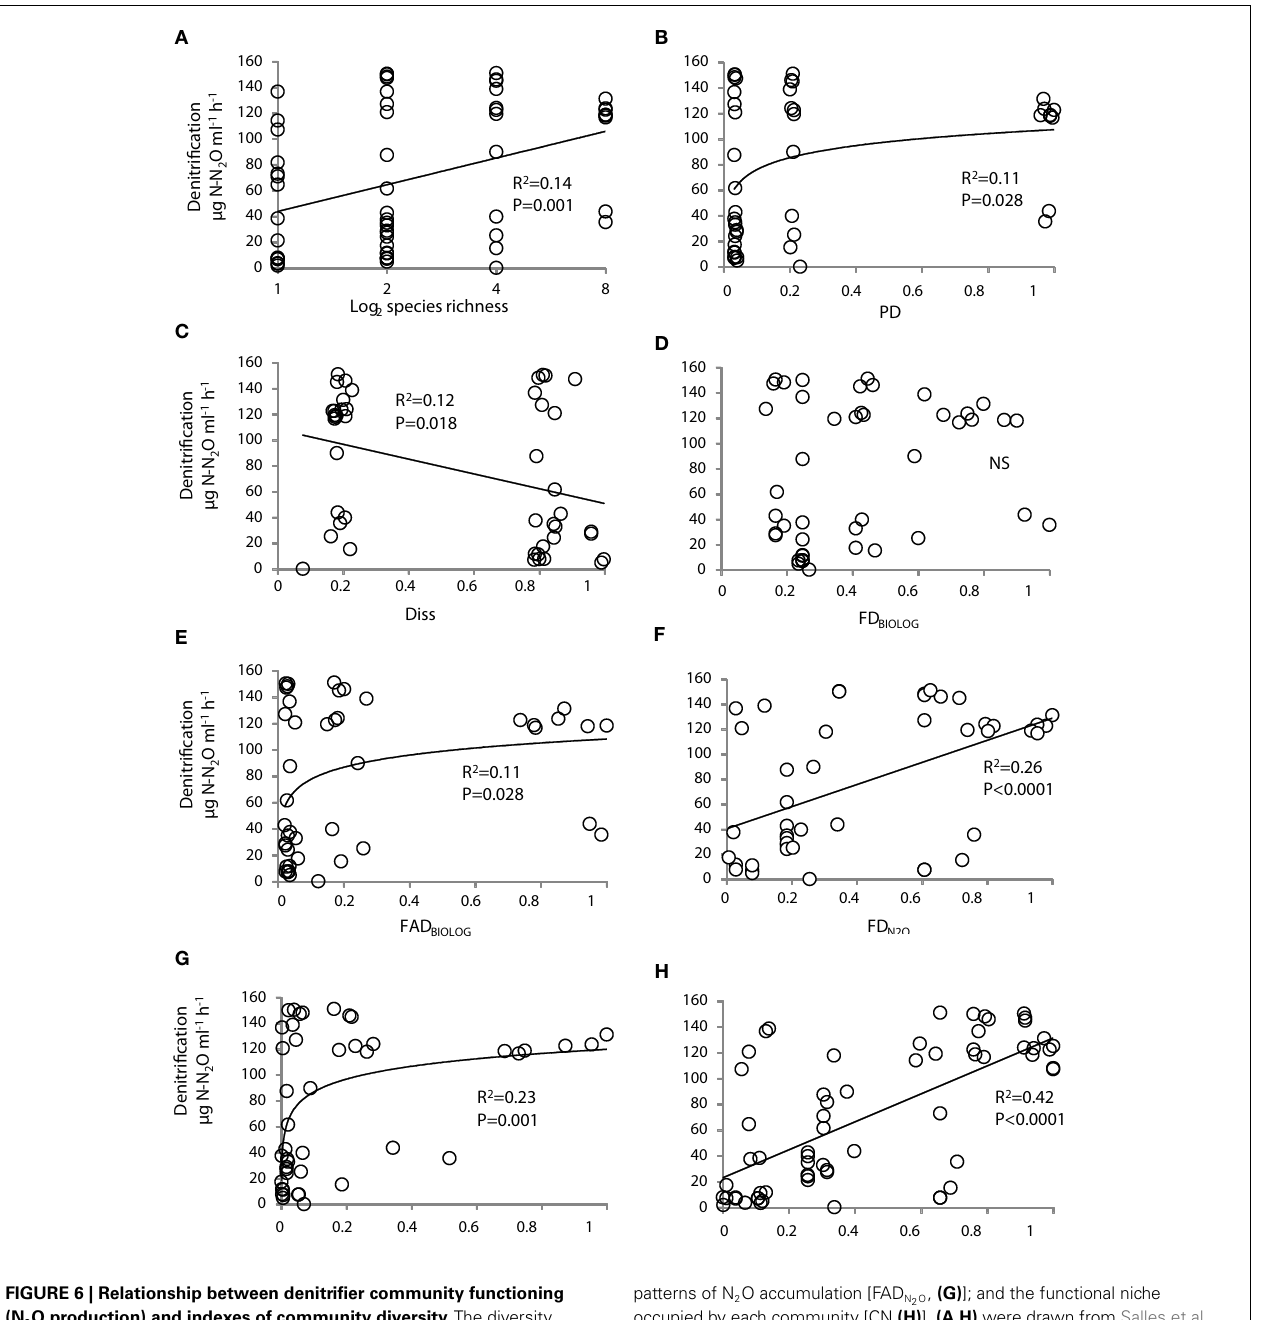
FIGURE 6 | Relationship between denitrifier community functioning (N 2 O production) and indexes of community diversity. The diversity measures were based on the number of species in the community [species richness (A) ]; the diversity of 16S rRNA gene sequences [phylogenetic diversity, PD (B) ]; dissimilarity in 16S rRNA gene sequences [Diss (C) ]; the functional diversity based on metabolic profiles [FD BIOLOG (D) ]; the functional attribute diversity based on metabolic profiles [FAD BIOLOG (E) ]; the functional diversity based on patterns of N 2 O accumulation [FD N2O , (F) ]; the functional attribute diversity based on